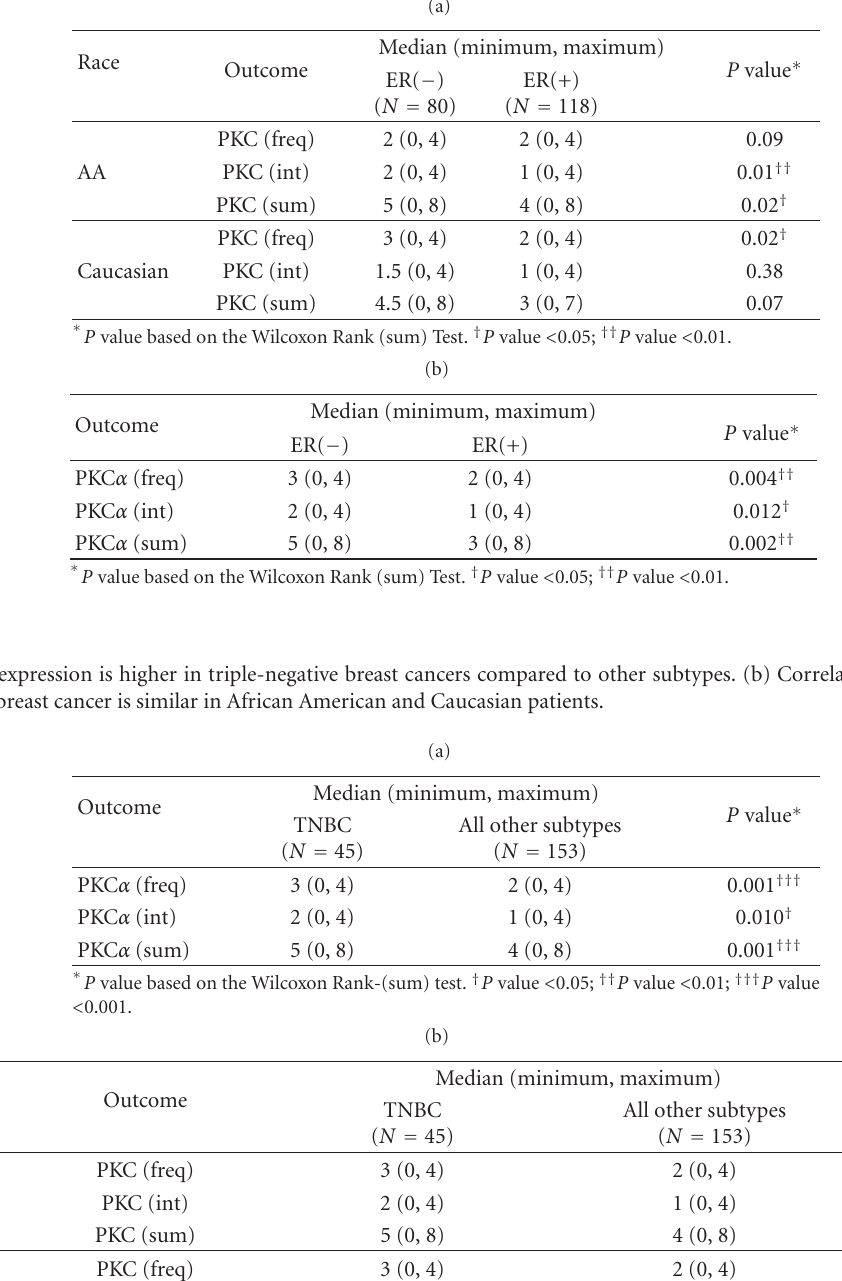
Table 3: (a) Relationship of ER α status and PKC α expression based on race. (b) ER α status and PKC α expression is inversely related.